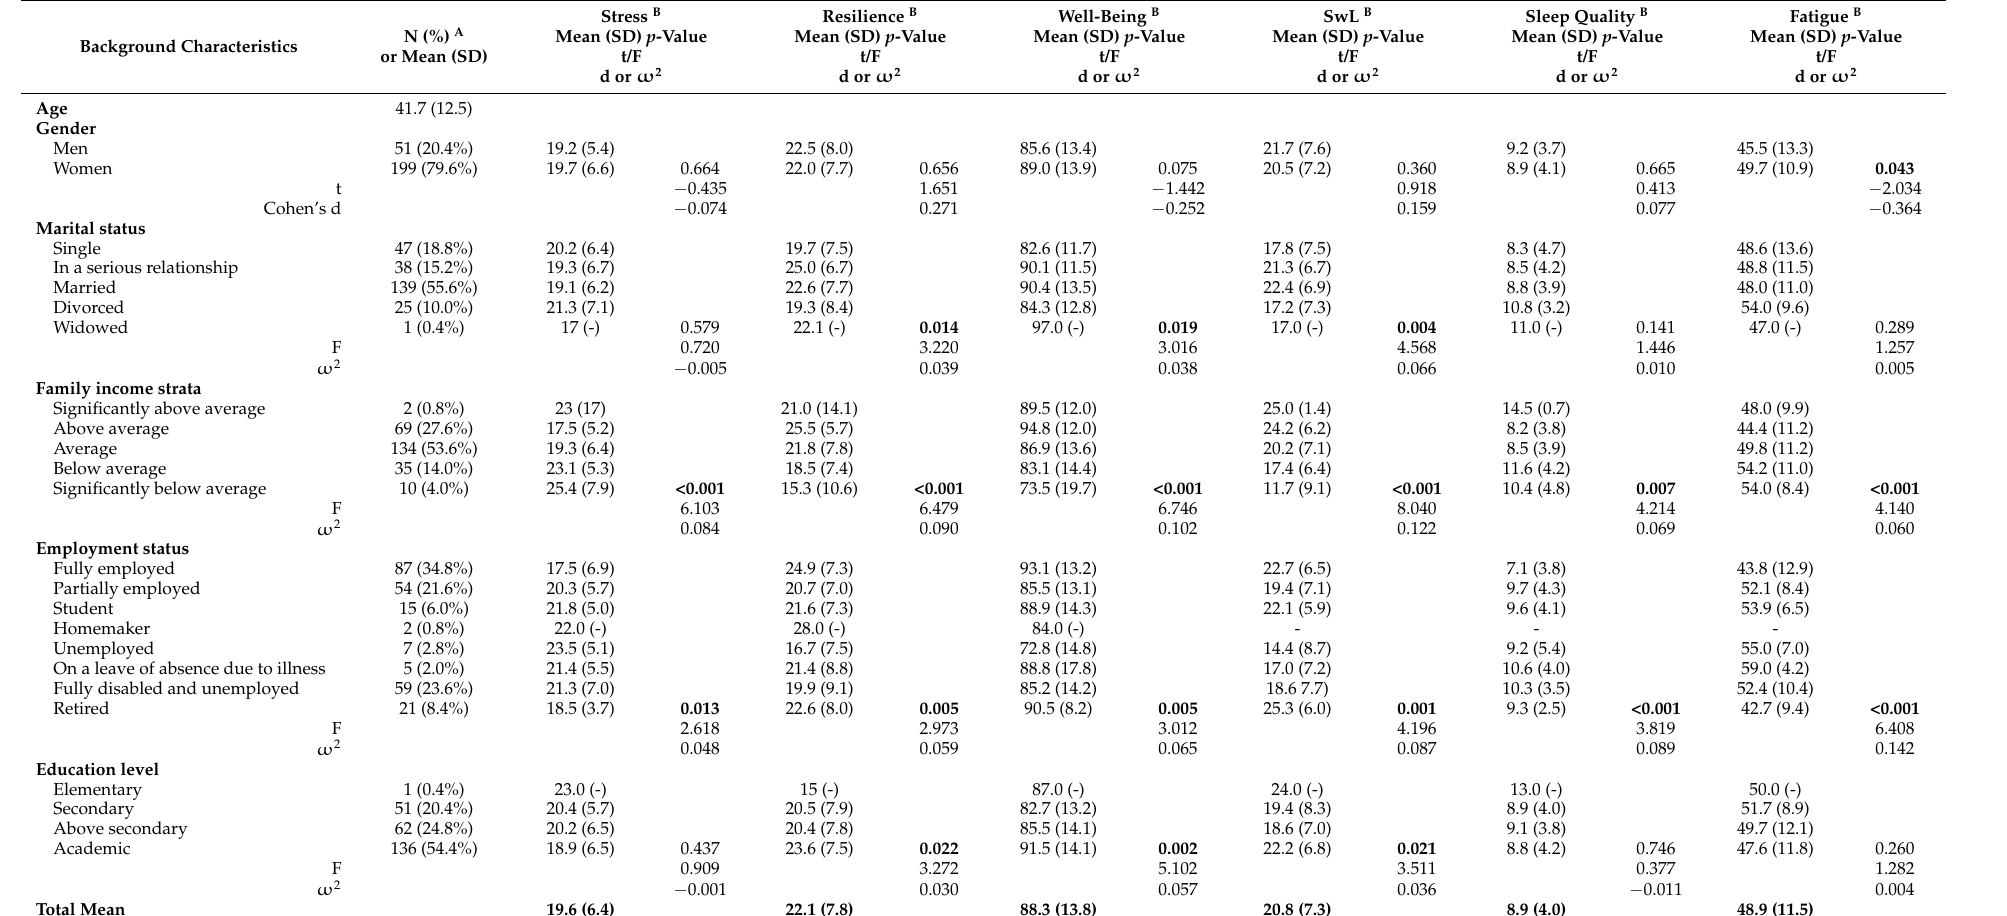
Table 1. Background